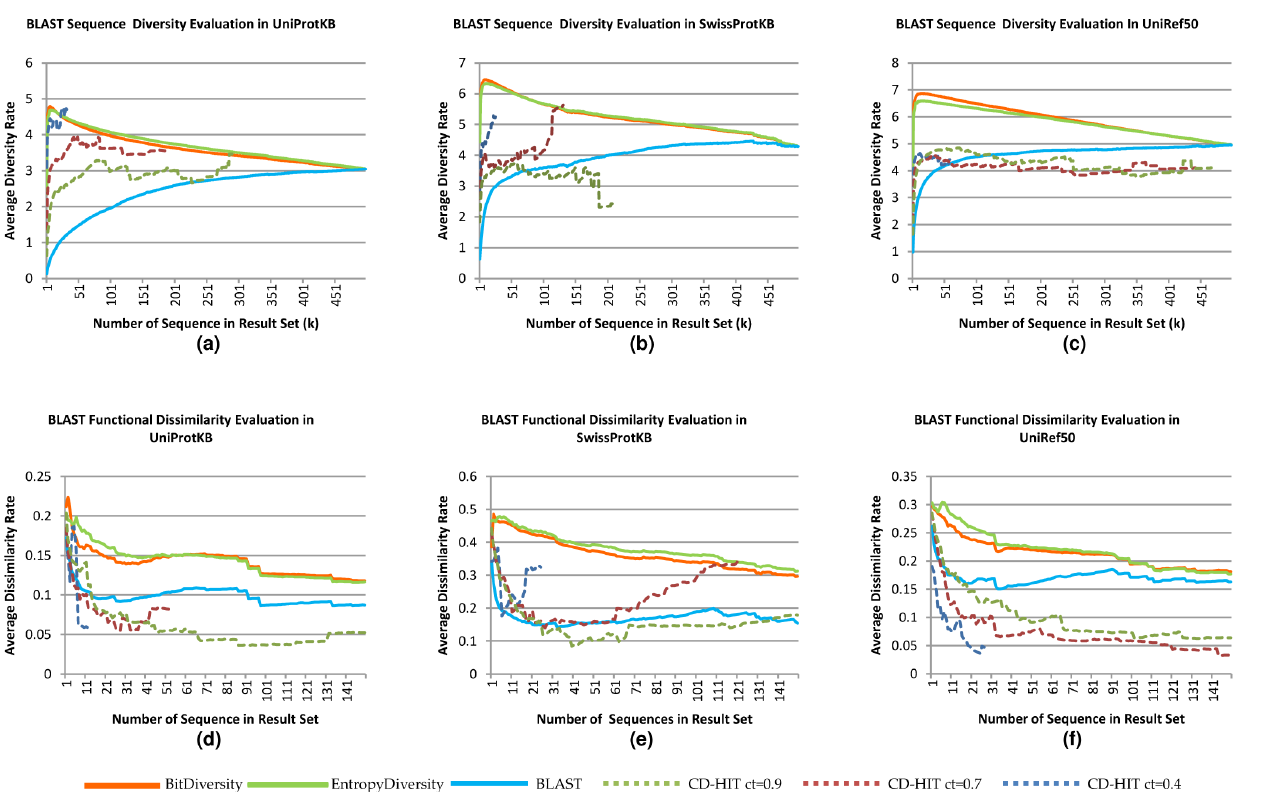
Fig. 4. Comparisons based on sequence diversity and functional dissimilarity measures in different databases: UniProtKB, SwissProtKB and UniRef50. The experiments are done by using OXBench dataset on BLAST Web services. For a, b, and c, the x axes represent the average sequence diversity rate calculated with Rao’s entropy method and the y axes show the size of the diversified set(k). For d, e, and f, the x axes represent the average functional dissimilarity rate based on Wang et al.’s similarity on molecular function GO DAG. The y axis is the same as the a, b, and